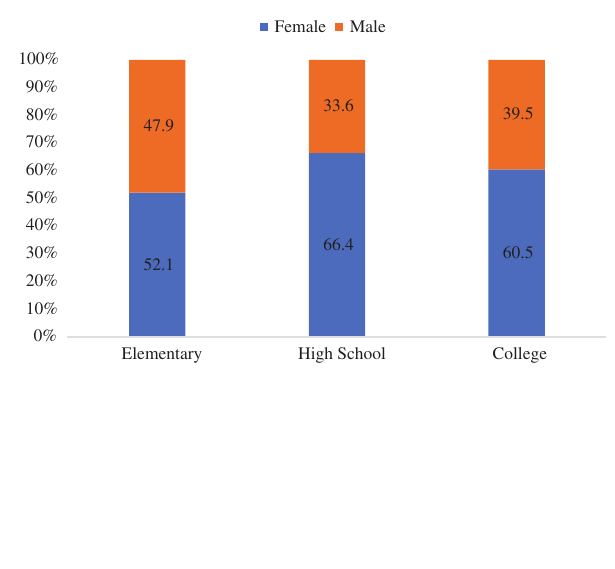
Cross-tabulation count of participants’ gender and educational attainment who perceived the climate change impact on coral reefs and seagrasses (n = 291). (The count was based on listwise deletion.) (Source: Authors, 2022.)